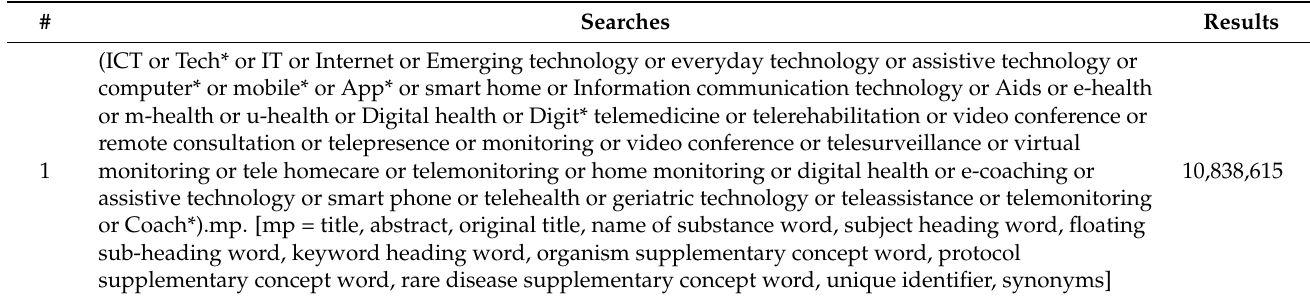
Table A1. Search strings applied within each electronic